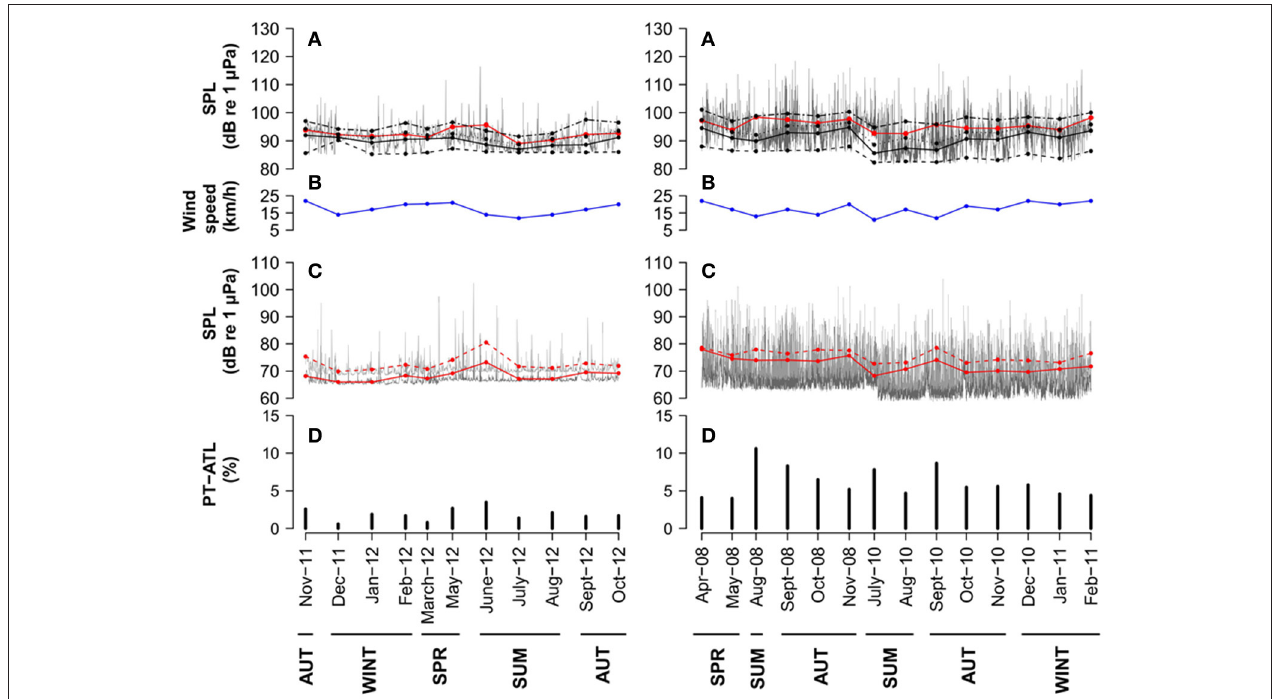
FIGURE 6 | Açores and Gigante seamount: (A) hourly (gray lines) and monthly averages (red lines), medians (black lines) and 5th, 75th, and 95th percentiles (dashed black lines from bottom to top) SPLs in the 1–1,000Hz frequency band. (B) monthly averaged wind speed (blue line). (C) hourly SPLs in the 63Hz (light gray lines) and 125Hz (dark gray lines) one-third octave bands and monthly averages (63Hz: red line and 125 Hz: dashed red line). (D) monthly PT-ATL. Months are grouped in seasons below the x axis. Seasons are described as follows: SPR, Spring (March–May); SUM, Summer (June–August); AUT, Autumn (September–November) and WINT, Winter